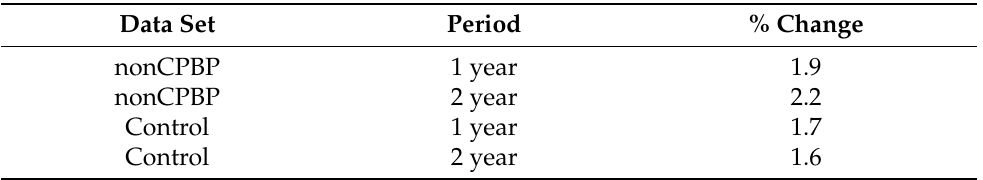
Table 3. Global warming: predicted % changes in capital relative to “no stress”, showing only small changes after 1 and 2